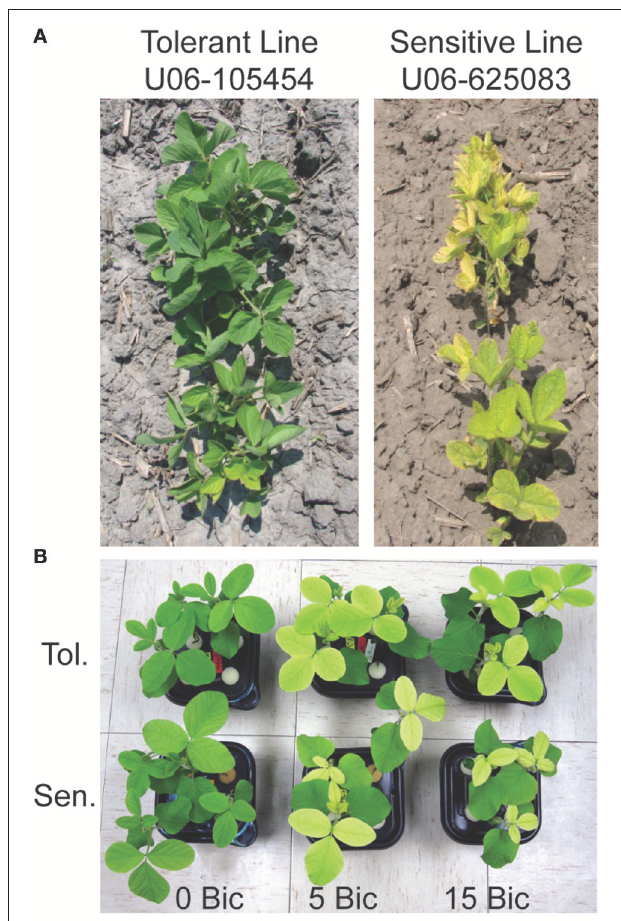
FIGURE 1 | Soybean lines used in this study at the V3 stage. (A) IDC tolerant line U06-454 and IDC sensitive line UO6-625083 in an alkaline field in North Bend, Nebraska, USA. (B) The IDC tolerant and sensitive lines in hydroponic solution with low Fe supply [1 µ M Fe(III)-EDDHA] and 0, 5, or 15mM sodium bicarbonate at 12 d after